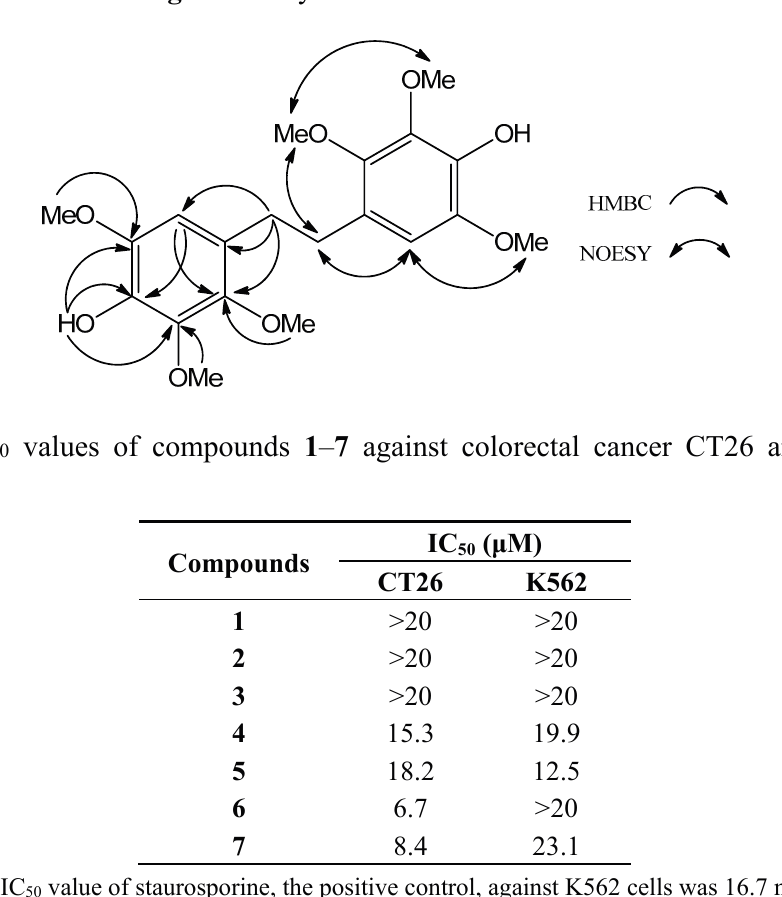
Figure 3. Key HMBC and NOESY of 2 .